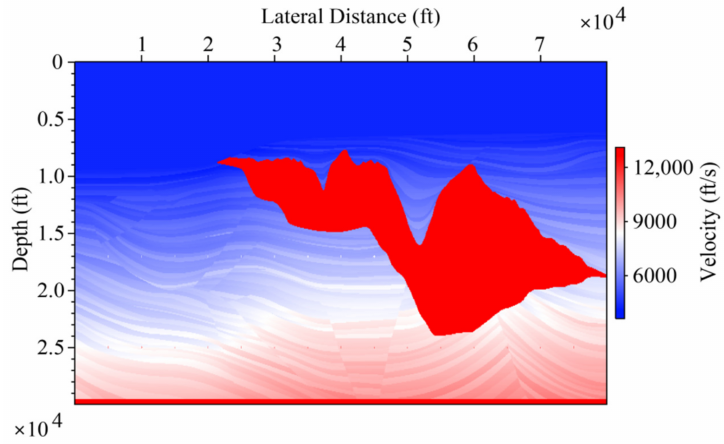
Figure 4. Sigsbee2B velocity